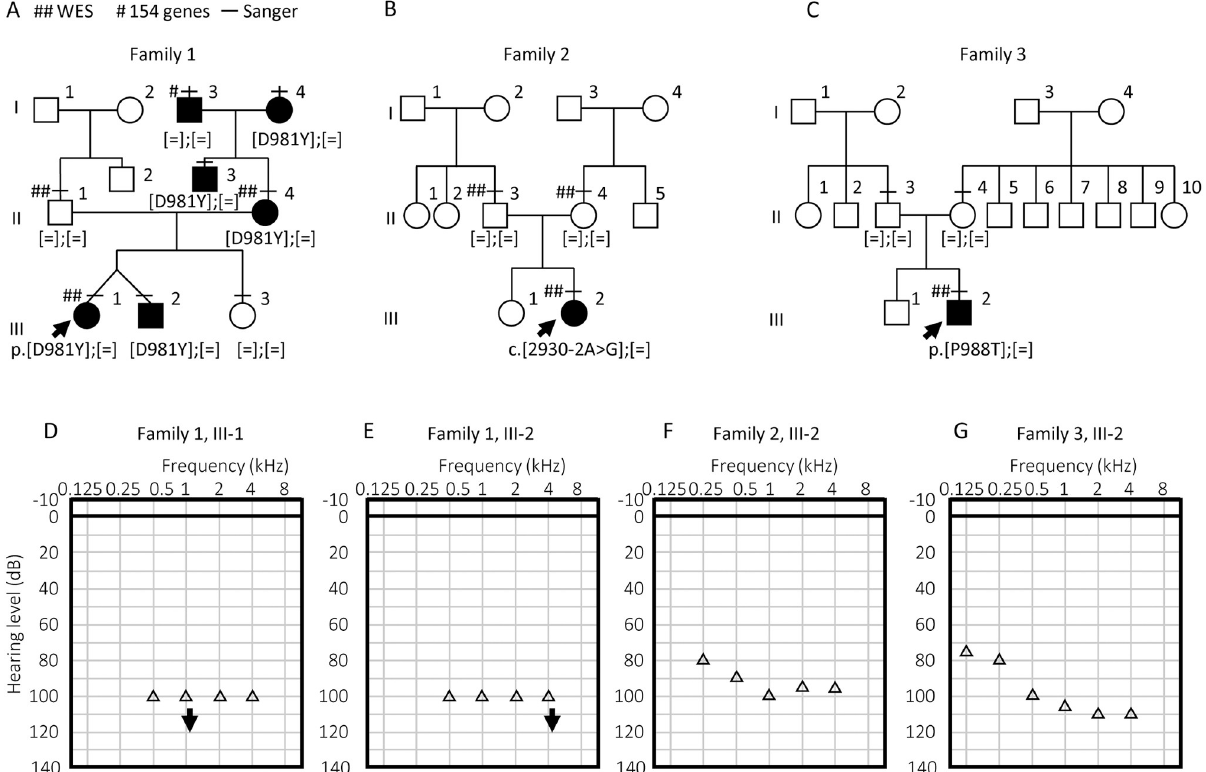
Fig 1. Subjects in this study. (A–C) Pedigrees of families 1 (A), 2 (B), and 3 (C). Arrows indicate probands. Double sharps (##), single sharps (#), and horizontal bars (–) indicate that individuals were subjected to WES, sequencing of deafness genes (154 genes), and/or Sanger sequencing for the specific variant (Sanger), respectively. SLC12A2 (NM_001046.2) genotypes are indicated below the symbol representing each subject. [=] indicates that the position of an allele was identical to the reference sequence. (D–G) Audiograms measured by conditioned orientation reflex audiometry of the proband (D) and her twin brother (E) in family 1, the proband of family 2 (F), and the proband of family 3 (G). Open triangles indicate thresholds measured in both ears. Downward arrows indicate that the hearing level was undetectable at the respective frequency of sound.